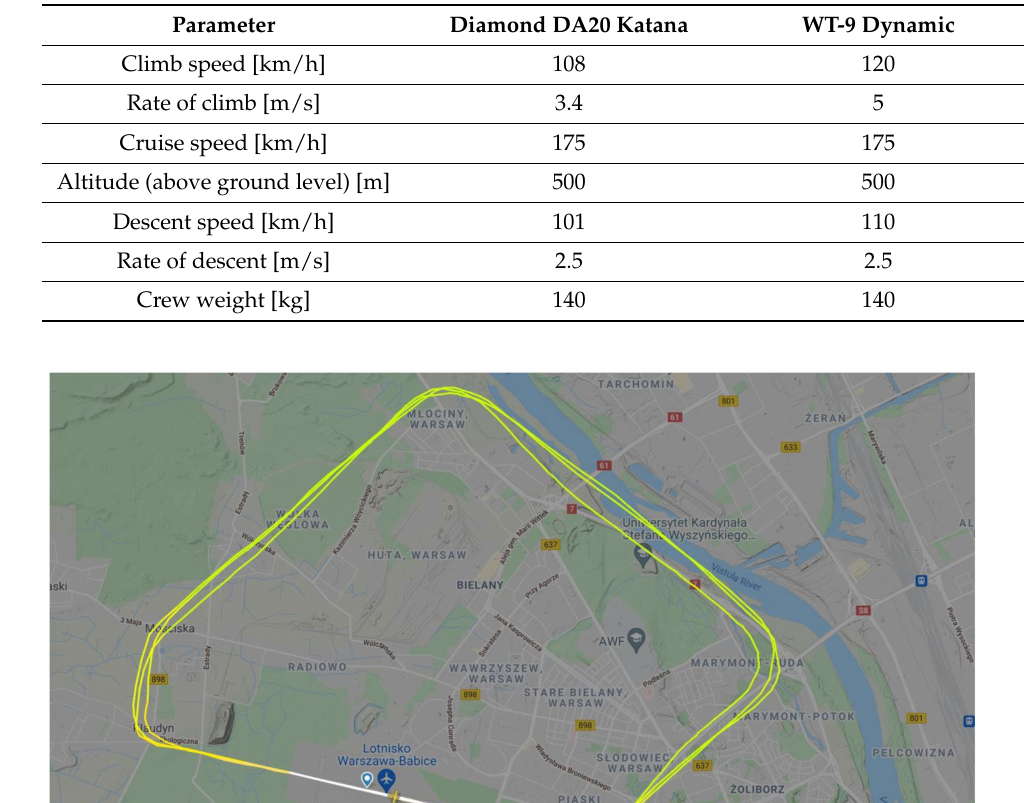
Table 4. Cross-country flight parameters.